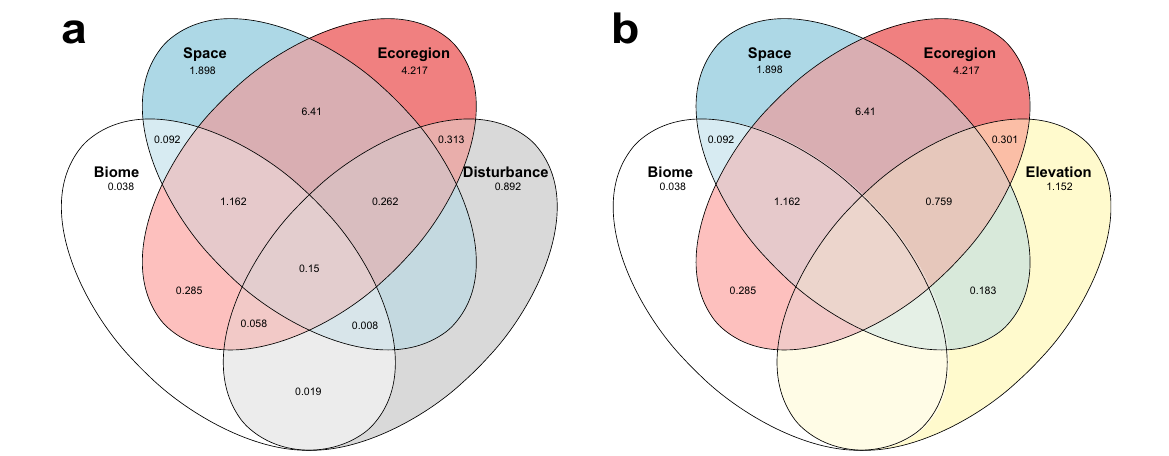
we show these two separate diagrams for visualization purposes, but Supplemen- tary Fig. 12 shows the effect of all our main predictor variables together. Note that we only plot our predictor variables of interest (i.e., not those used for controlling sampling effects). Terms that reduce explanatory power are not shown. Source data are provided as a Source Data fi